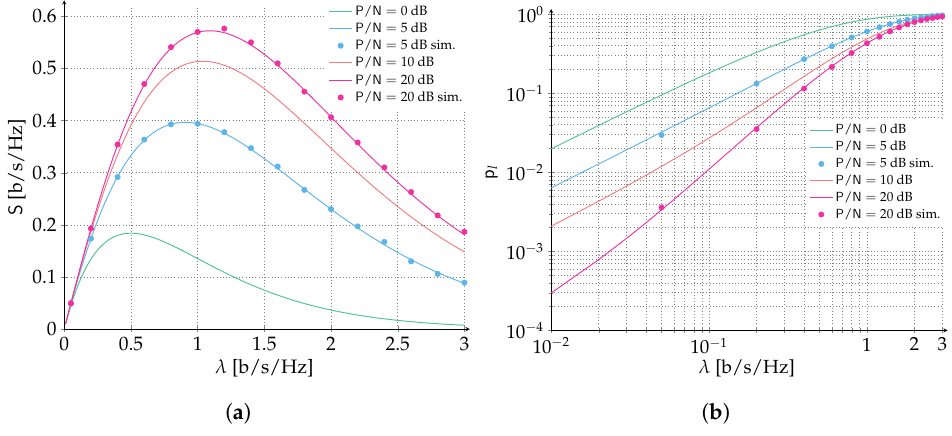
Figure 3. Performance of ALOHA with forward error correction. Data units are protected with a Gaus- sian codebook of rate R = 1 bits per symbol. We select the SNR in the range P / N Analytical results (continuous lines) are compared with Monte Carlo simulations (dots). ( a ) Spectral efficiency; ( b ) Packet loss